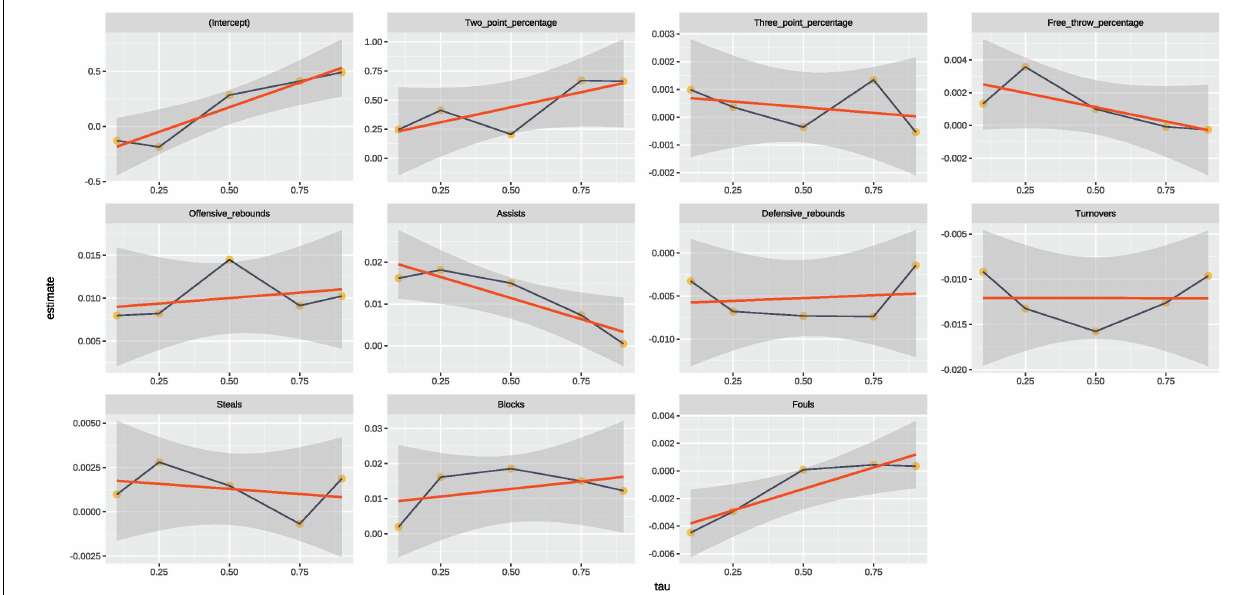
FIGURE 1 | Regression coefficients of MLR and QR modeling for the effects of key performance indicators on match outcome.